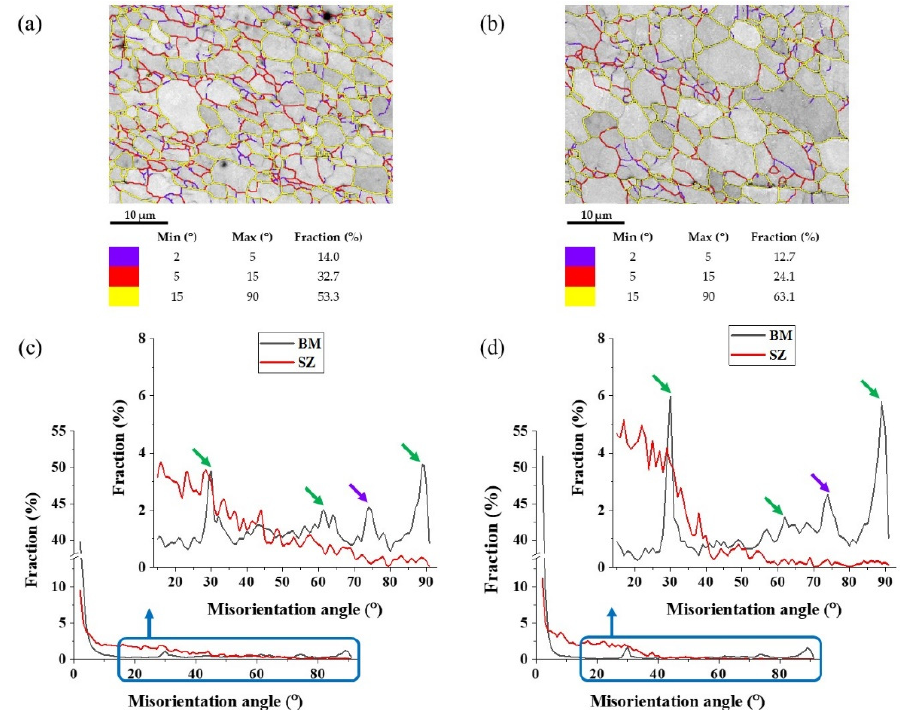
Figure 5. Boundary maps of ( a ) fine-grained SZ and ( b )ultra-fine-grained SZ are shown with quan- titative numerical values of GBCD of each. Misorientation angle distribution in BM and SZ of ( c ) fine-grained and ( d ) ultra-fine-grained. The graphs show the misorientation angle ranges of 2 to 90°, and the inset graphs show the misorientation angles of 15 to 90° (enlarged plot of blue box areas). The black lines and red lines represent BM and SZ, respectively.